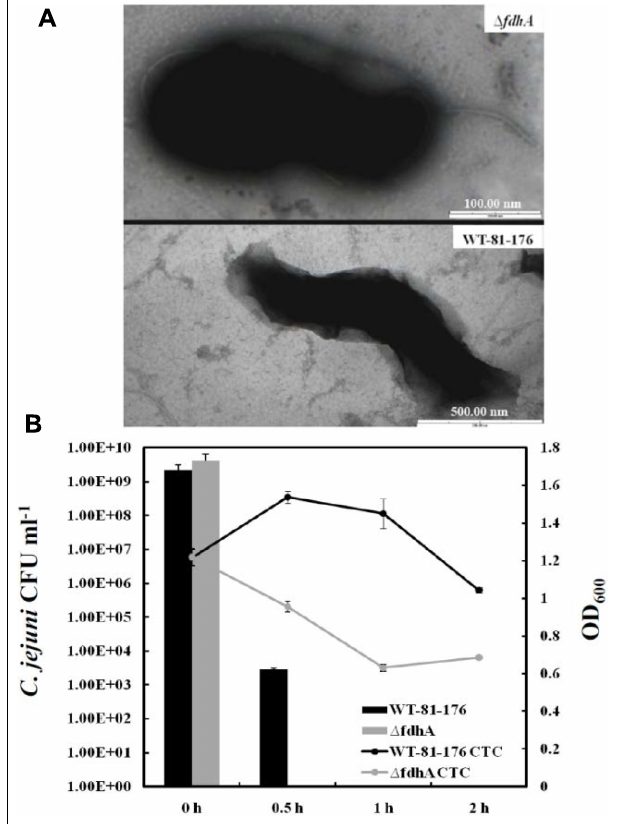
FIGURE 1 | (A) Transmission electron microscopy images of the C. jejuni 81-176 wild-type strain and its formate dehydrogenase mutant ( (cid:2) fdhA ) that is defective in the metabolism of formate.The (cid:2) fdhA cells exhibited a “rounding up”/spherical morphology, which was also observed in our previous work analyzing the (cid:2) fdhA of the C. jejuni NCTC-11168 wild-type strain (Kassem etal., 2012). (B) CFU enumerations and viability curves of the C. jejuni 81-176 wild-type and the (cid:2) fdhA after exposure to formic acid (pH = 4.0; Kassem and Rajashekara, unpublished).The CFU were determined by plating on Mueller-Hinton agar, while the viability curve was constructed by staining with 5-cyano-2,3-ditolyl-tetrazolium chloride (CTC), which was used to determine the respiratory activity (hence viability) as described in Gangaiah etal. (2009) and elsewhere.